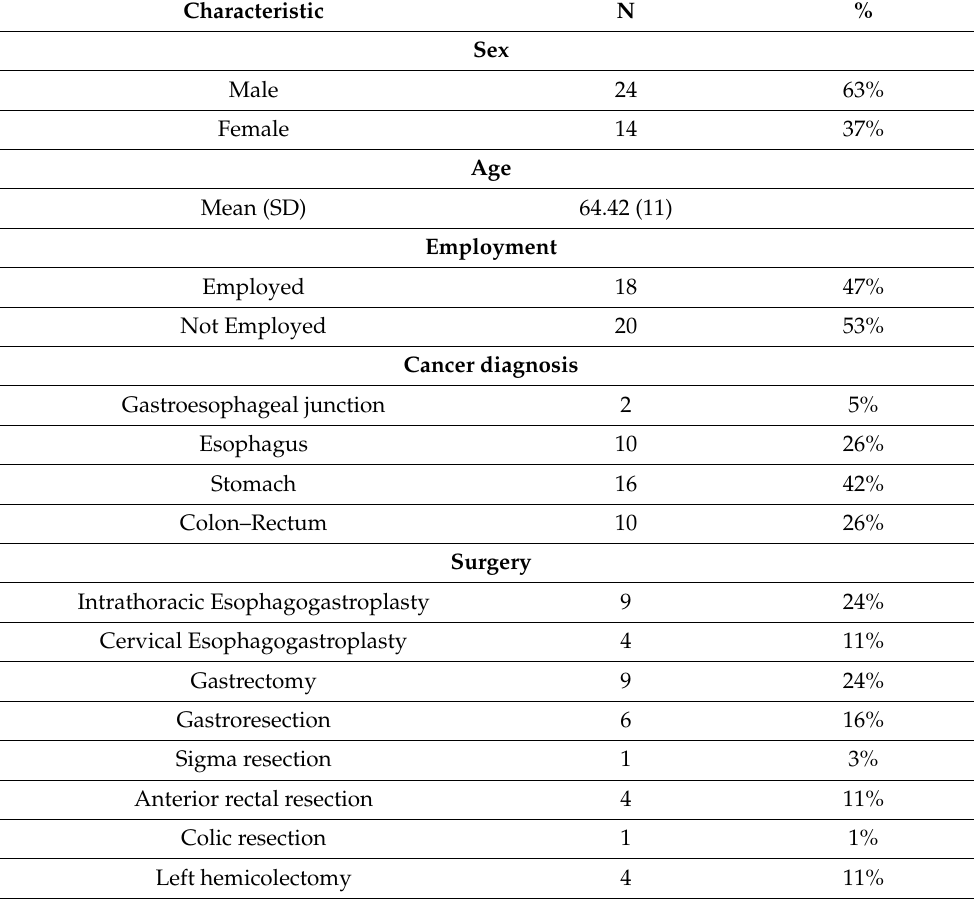
Table 3. Characteristics of the patients who completed the